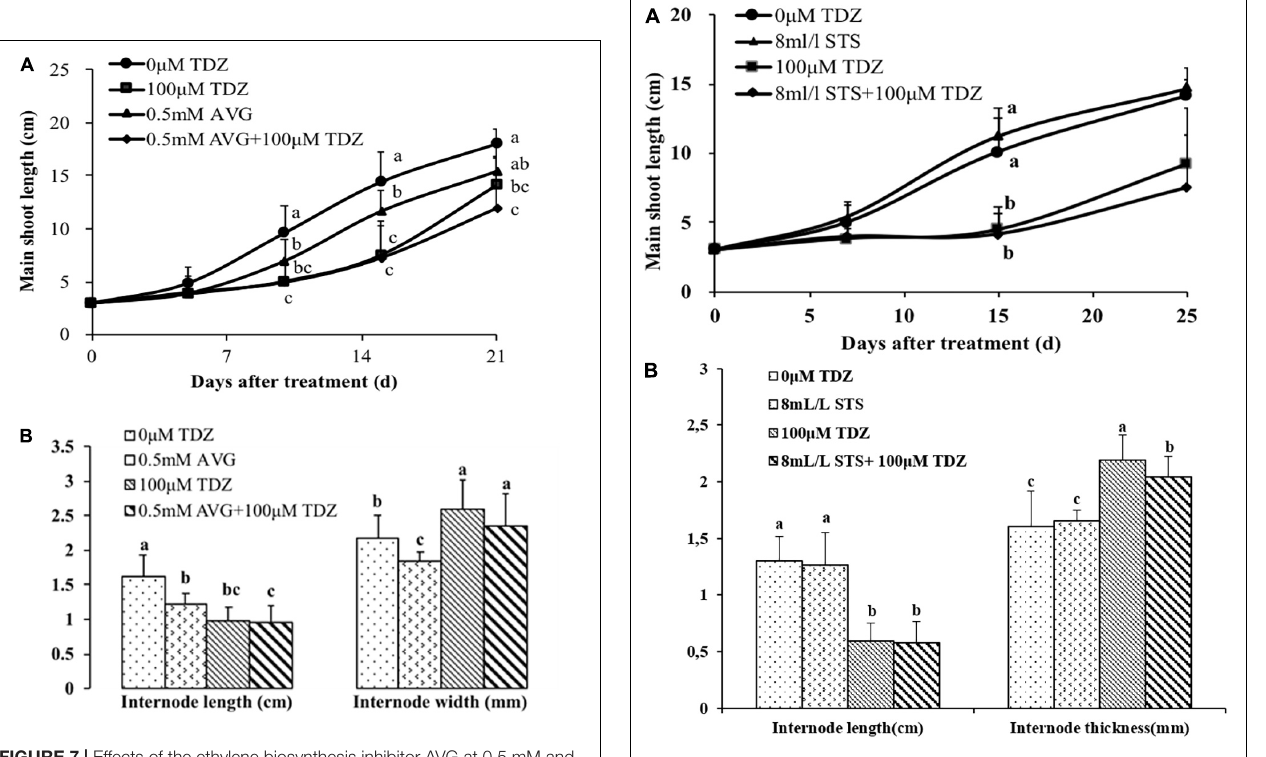
Frontiers in Plant Science |